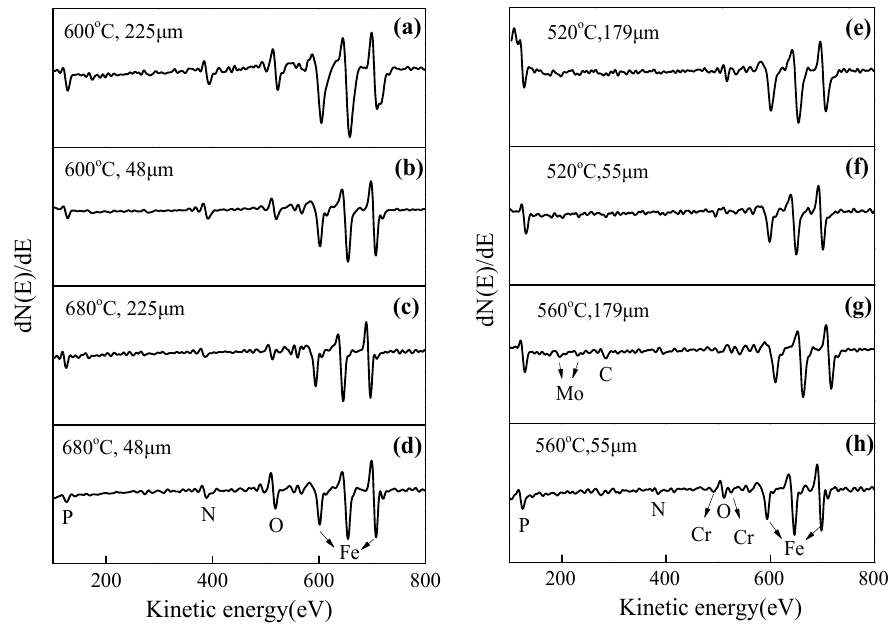
Figure 3. AES spectra of the specimens with different grain sizes for both IF and 2.25Cr-1Mo steels, aged at different temperatures (IF steel ( a – d ); and 2.25Cr-1Mo steel ( e – h )).